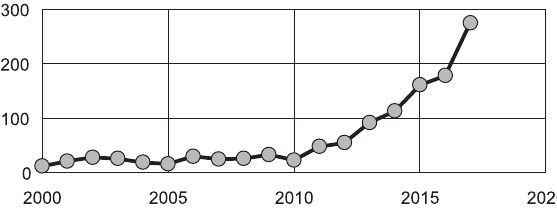
Fig. 1. An increase in citations of articles published in Quaestiones Geographicae in the 21 st century according to Scopus, a scientific data base, carried out by the publishing company Elsevier (the state as at 1 March